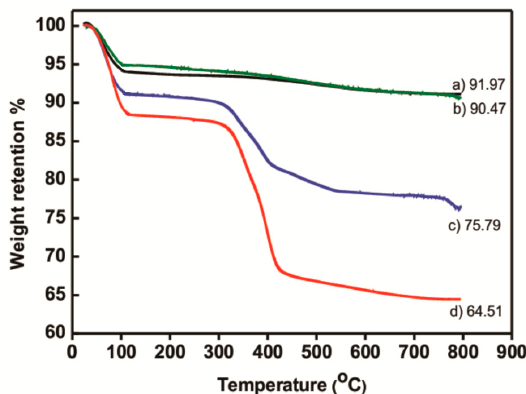
Figure 3. TGA of ( a ) bare silica microspheres; ( b ) BiBB-functionalized silica microspheres and silica microspheres possessing grafted PNIPAM brushes through SI ATRP for ( c ) 12 and ( d ) 16 h. SEM images were recorded for silica microspheres, SiO 2 -Br, and SPMs, below and above the